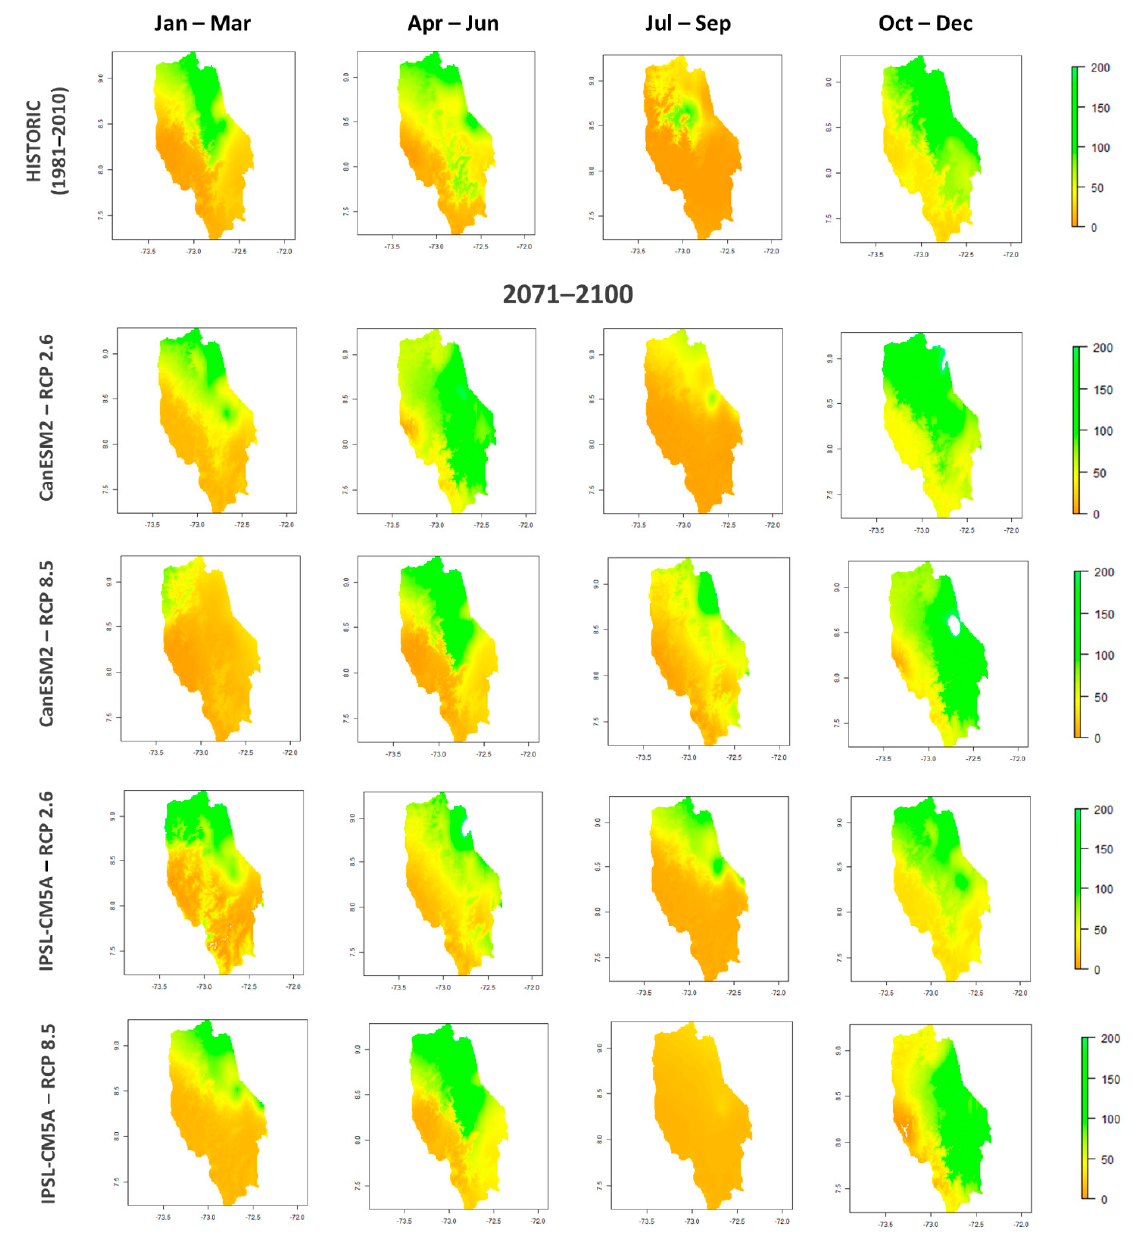
Figure B2. Stream Flow 2071–2100 Figure A6. Stream Flow